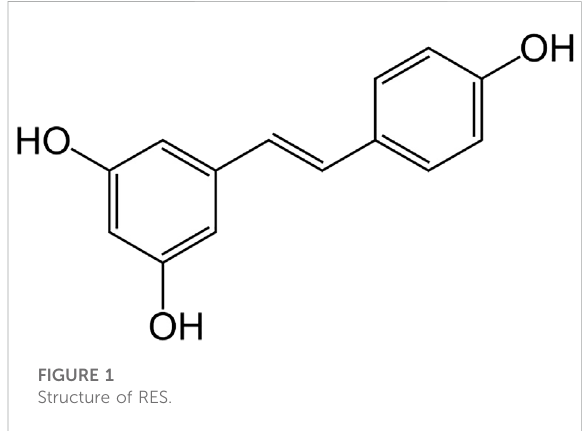
FIGURE 1 Structure of